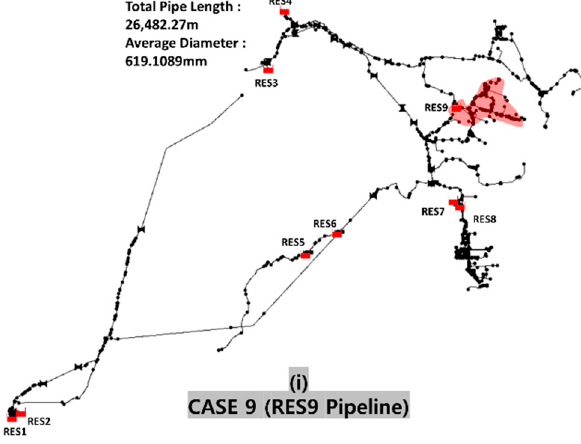
Figure 4. The Nine Critical Paths in the A-City Industrial Water Supply Network.